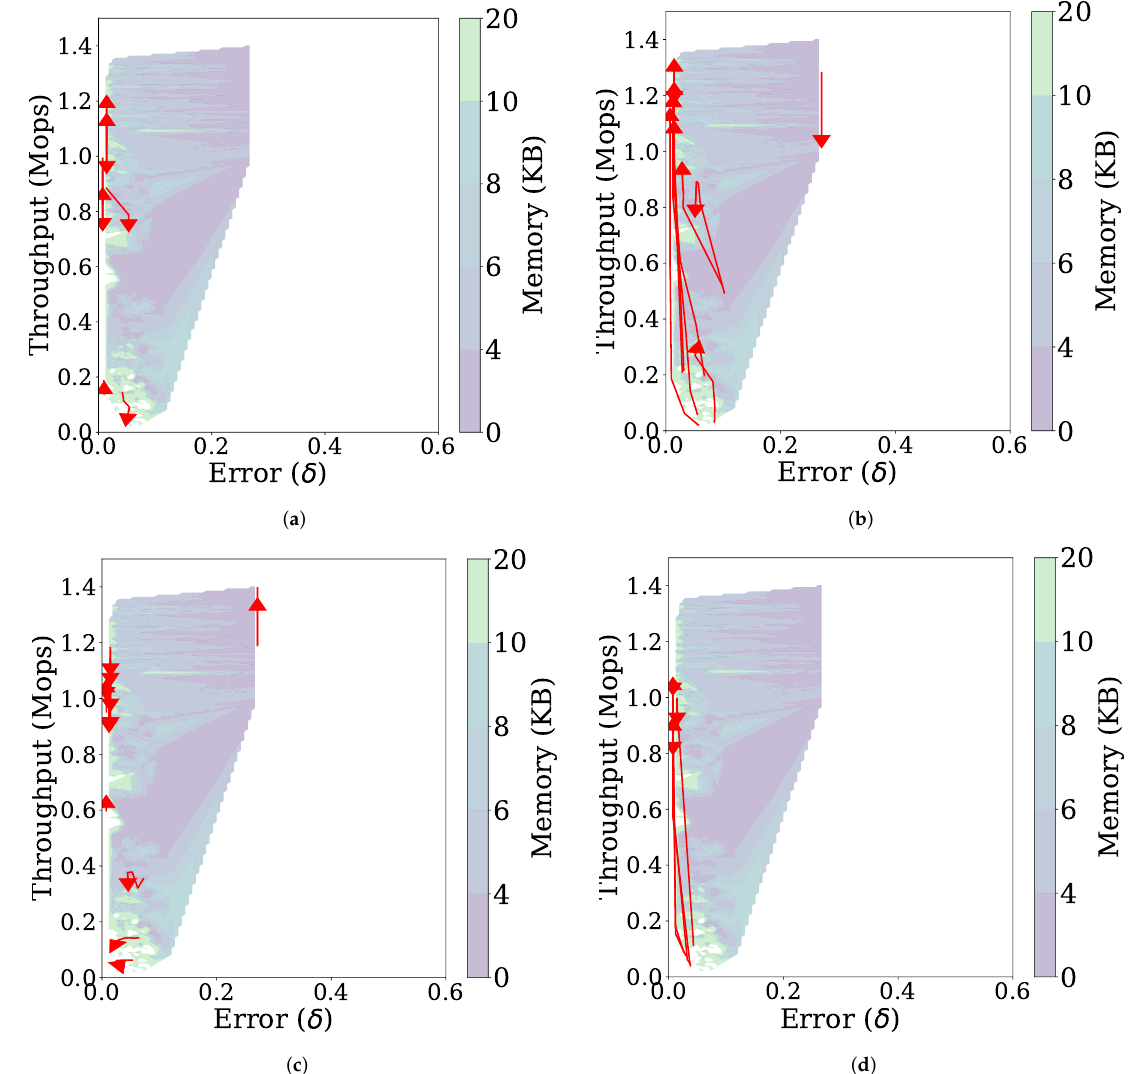
Figure 11. Trajectories (represented by red arrows) of the performance of FlexSketch for the stationary data stream as the value of each parameter increases ( a ) N M ( b ) N Q ( c ) λ ( d ) γ